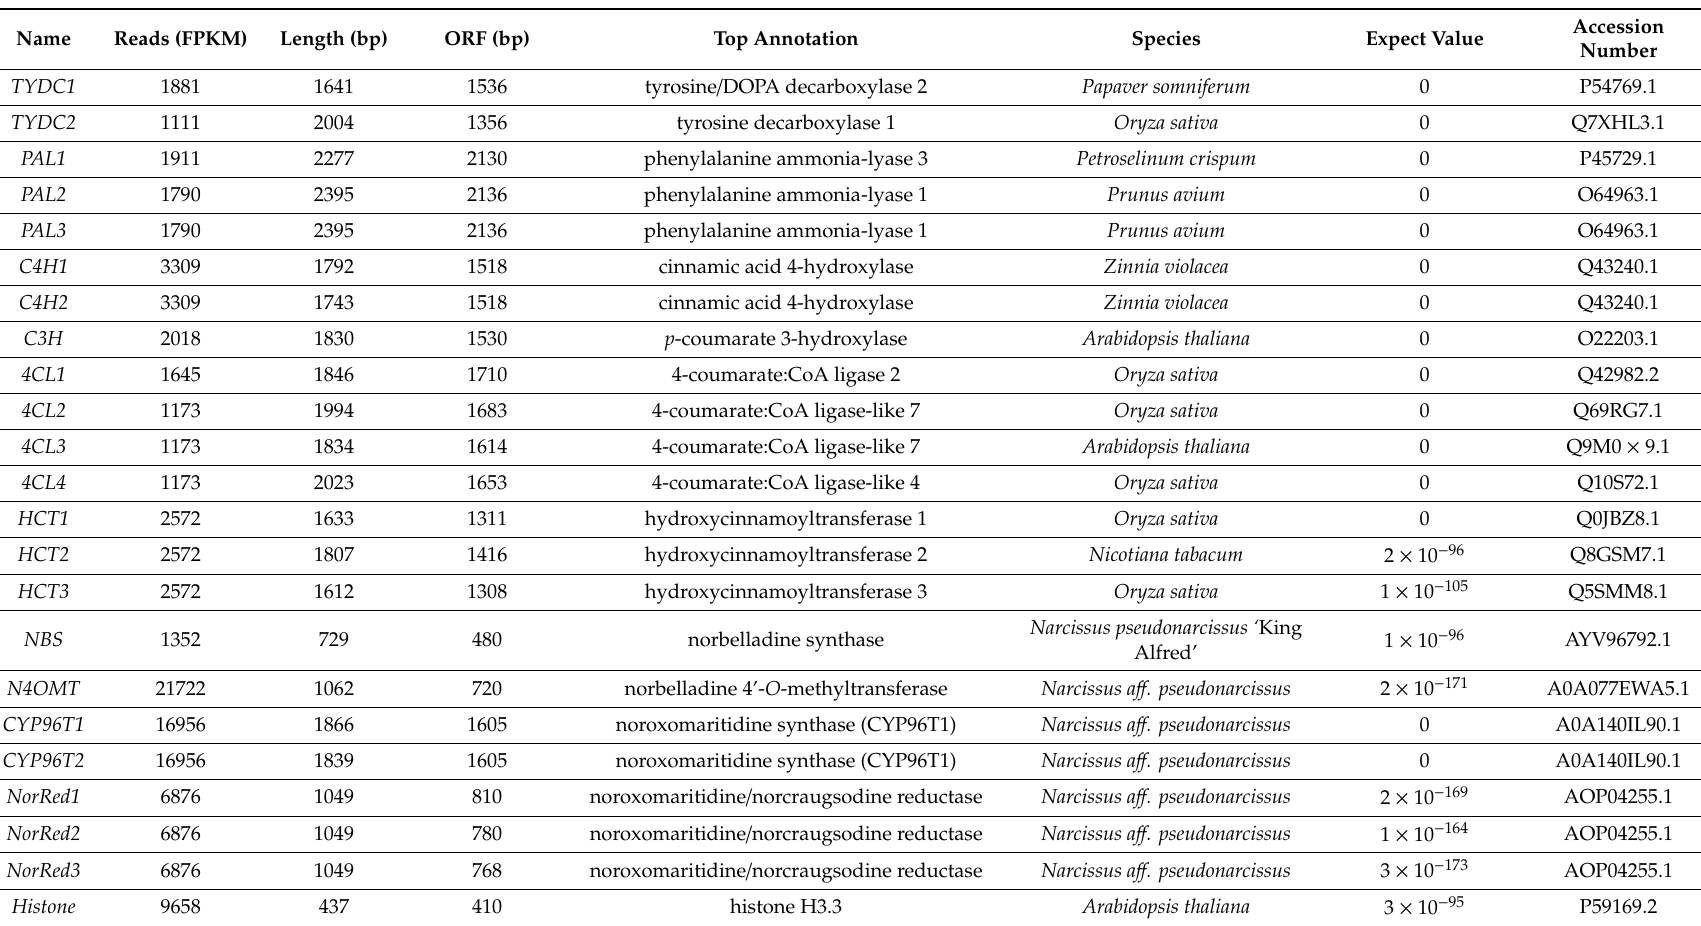
Table 2. Summary of the biosynthetic genes identified in the N. papyraceus transcriptome known to be involved in Amaryllidaceae alkaloid